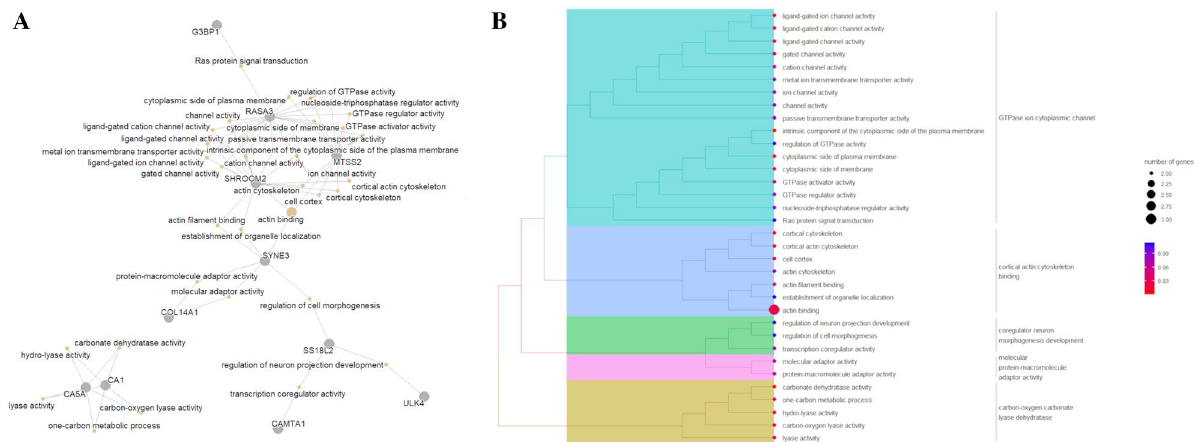
Figure 3. Functional analysis for the genes harboring differentially methylated regions for the interaction term (NutChal * FatGroup) of the multifactorial model. ( A ) Network composed of genes (gray circles) and gene ontology (GO) terms (yellow circles) showing the functional connection between the genes harboring DMRs identified for the interaction term (NutChal * FatGroup). ( B ) Functional grouping tree diagram for the annotated GO terms. Each color in the dendrogram represents a functional group obtained after estimating the Jaccard correlation coefficient. The area of the circles represents the number of genes assigned to each GO term, and the color of the circle indicates the P value estimated for each GO